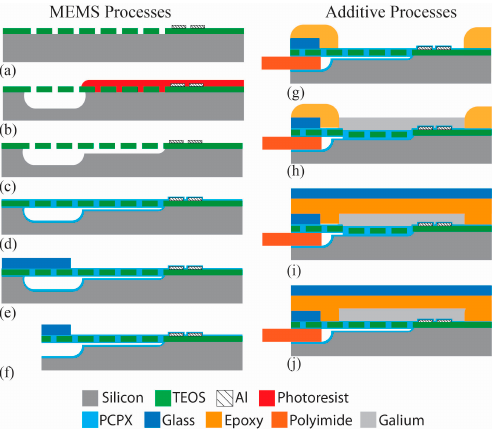
Figure 4. Micropump fabrication process with direct write integration over classic Micro